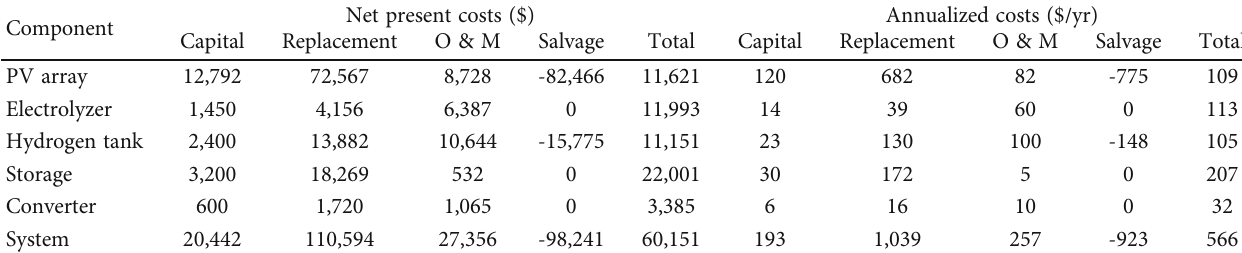
Table 10: Present worth and annualized value of all costs over 30